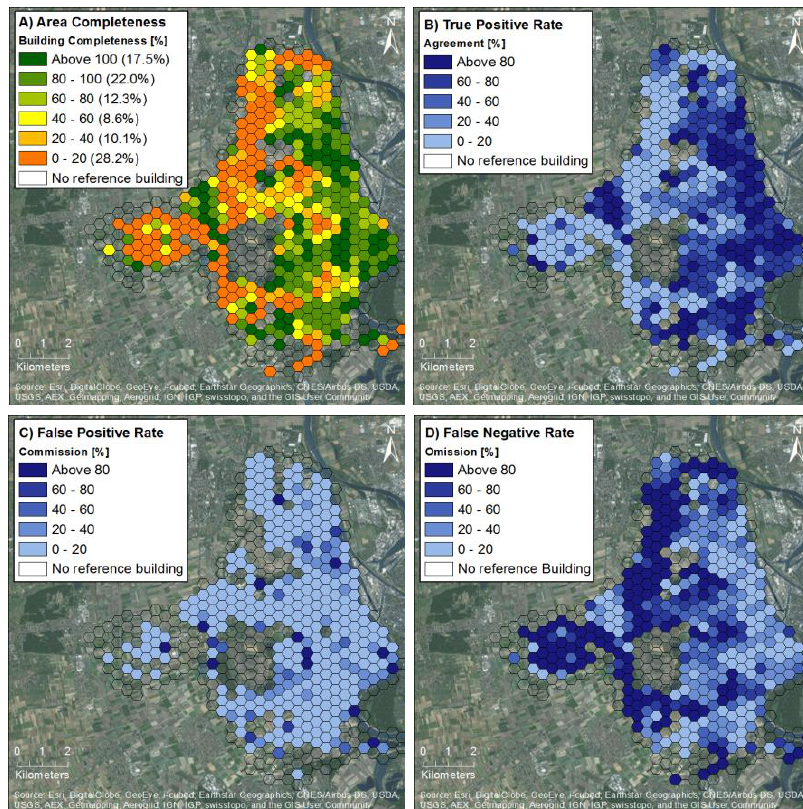
Figure 5. Building completeness in OSM estimated with the building area ratio (A), as well as the true positives rate (B), false positive rate (C) and false negative rate